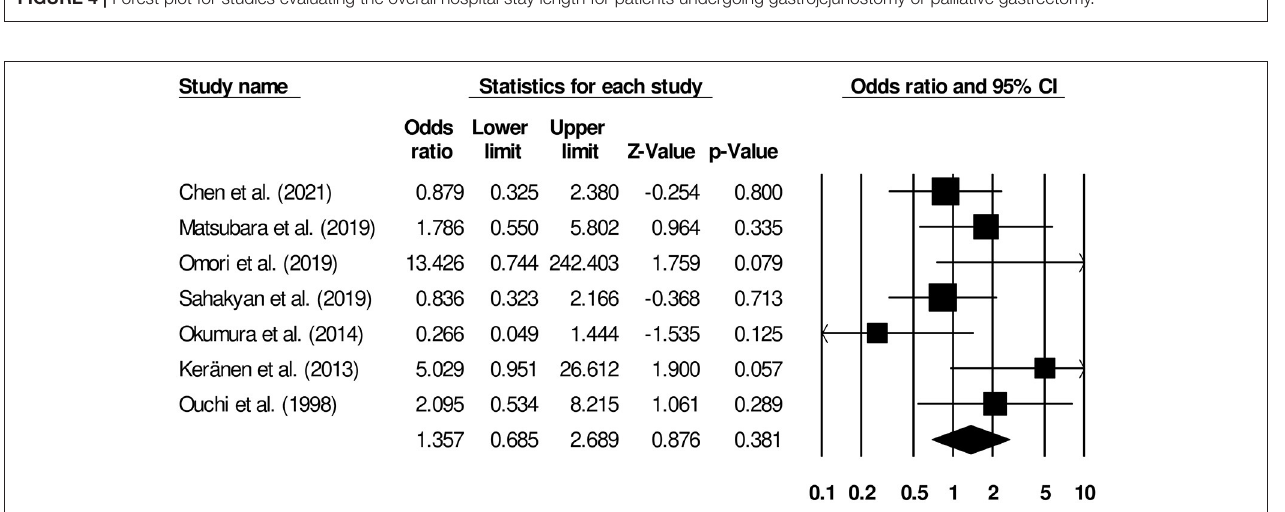
FIGURE 4 | Forest plot for studies evaluating the overall hospital stay length for patients undergoing gastrojejunostomy or palliative gastrectomy.